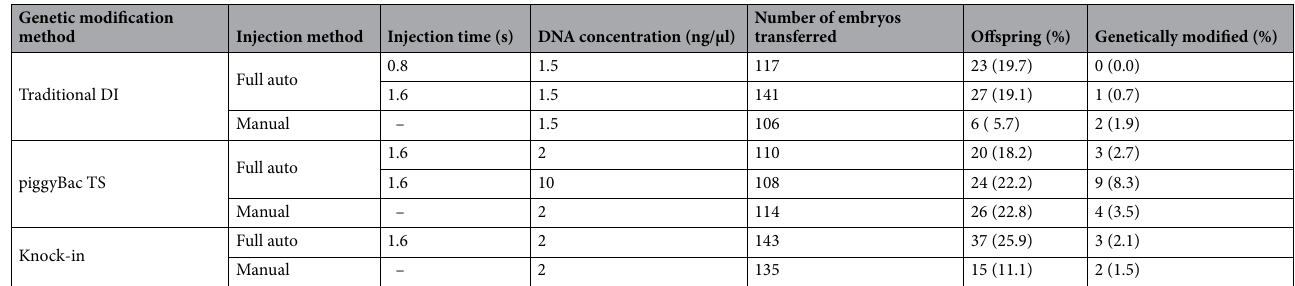
Table 1. Offspring and genetic modification of zygotes injected into the pronucleus with solutions used for 3 different genetic modifications. The Offspring and Genetically modified percentages were calculated using the number of embryos transferred as the